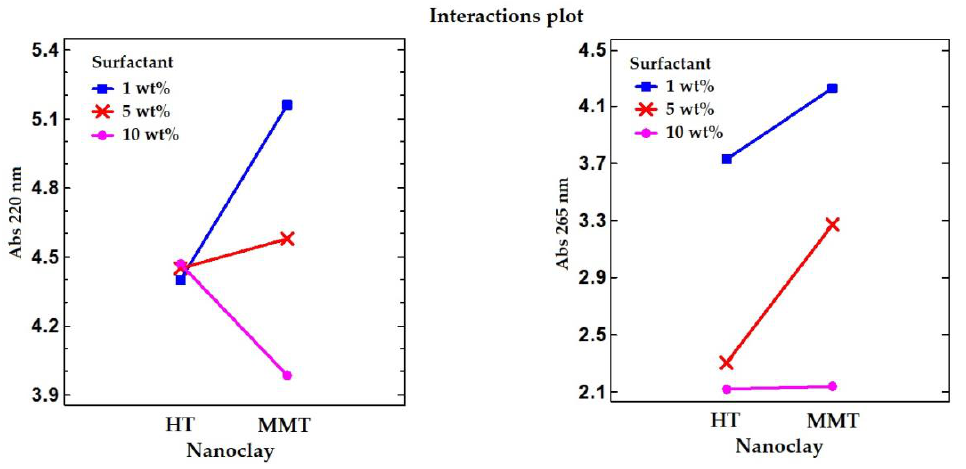
Figure 2. Interactions plot between type of nanoclay (HT and MMT) and surfactant concentration (SDS for HT or CPB, for MMT at 1, 5, 10 wt%) with limonene absorption at 220 nm ( left ) and 265 nm ( right ), in the separated solvents.